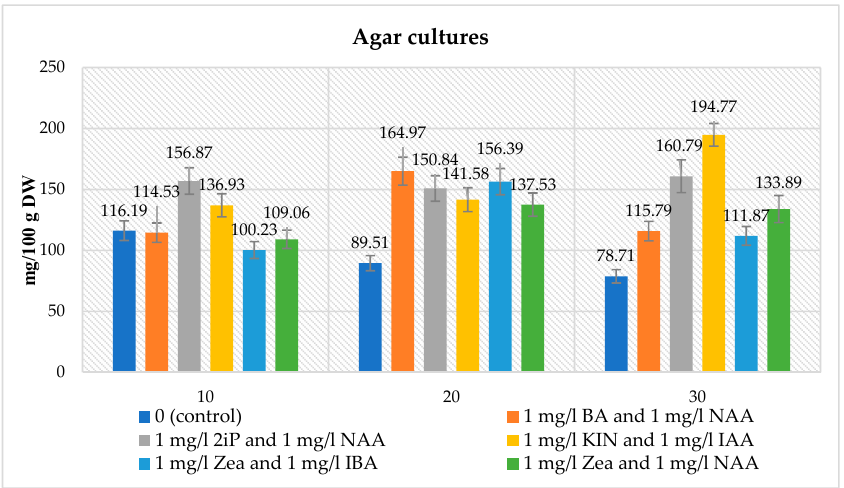
Figure 2. The maximal total glucosinolate contents (mg/100 g DW ± SD) in the extracts from agar N. officinale microshoot cultures of tested different MS medium variants and growth cycles.